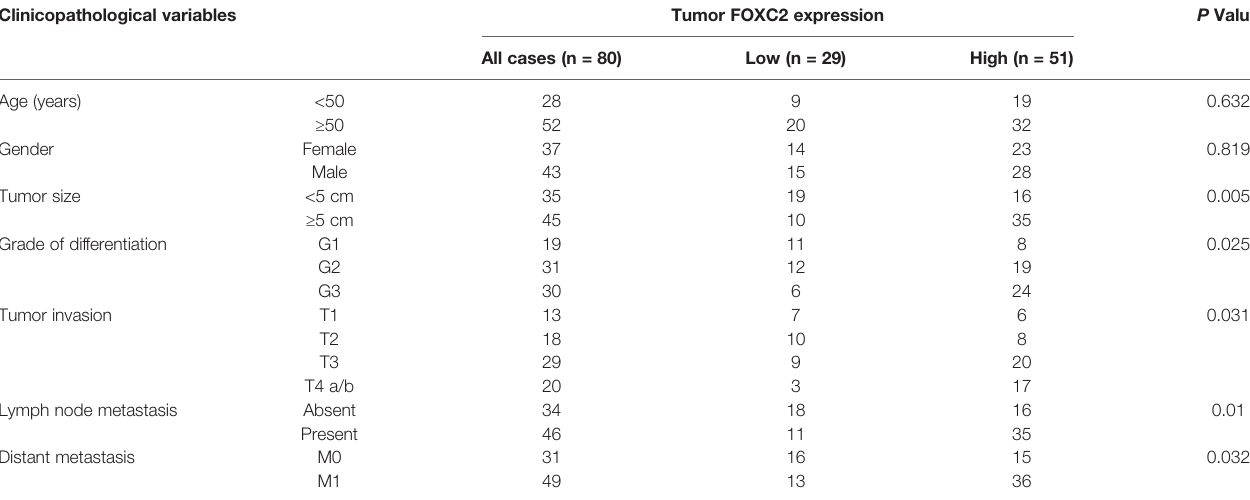
TABLE 2 | Correlation of FOXC2 expression and patients ’ clinicopathological variables in GC tissues. Clinicopathological variables Tumor FOXC2 expression P